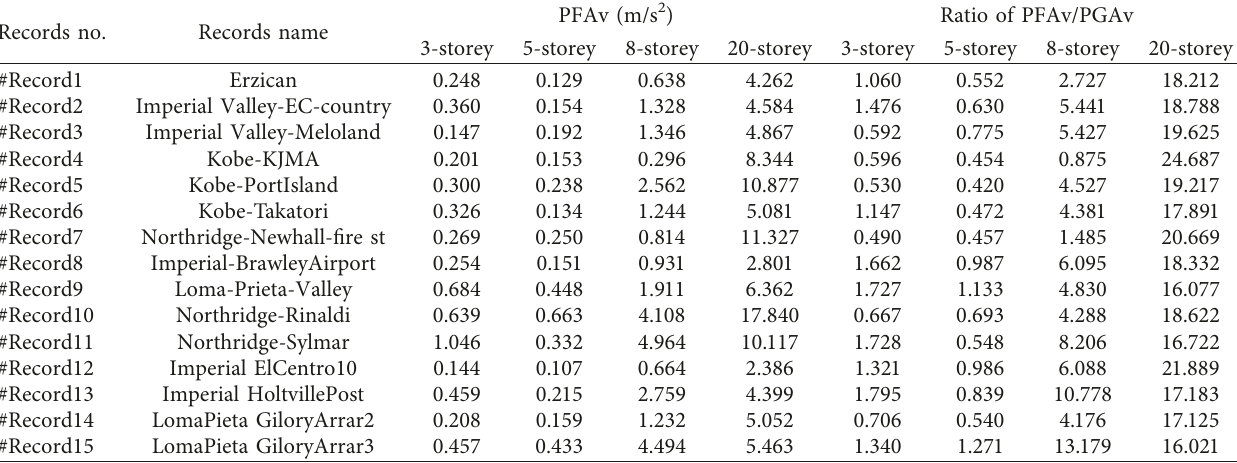
Table 9: Ratios of PFAv/PGAv for the near-field earthquakes.